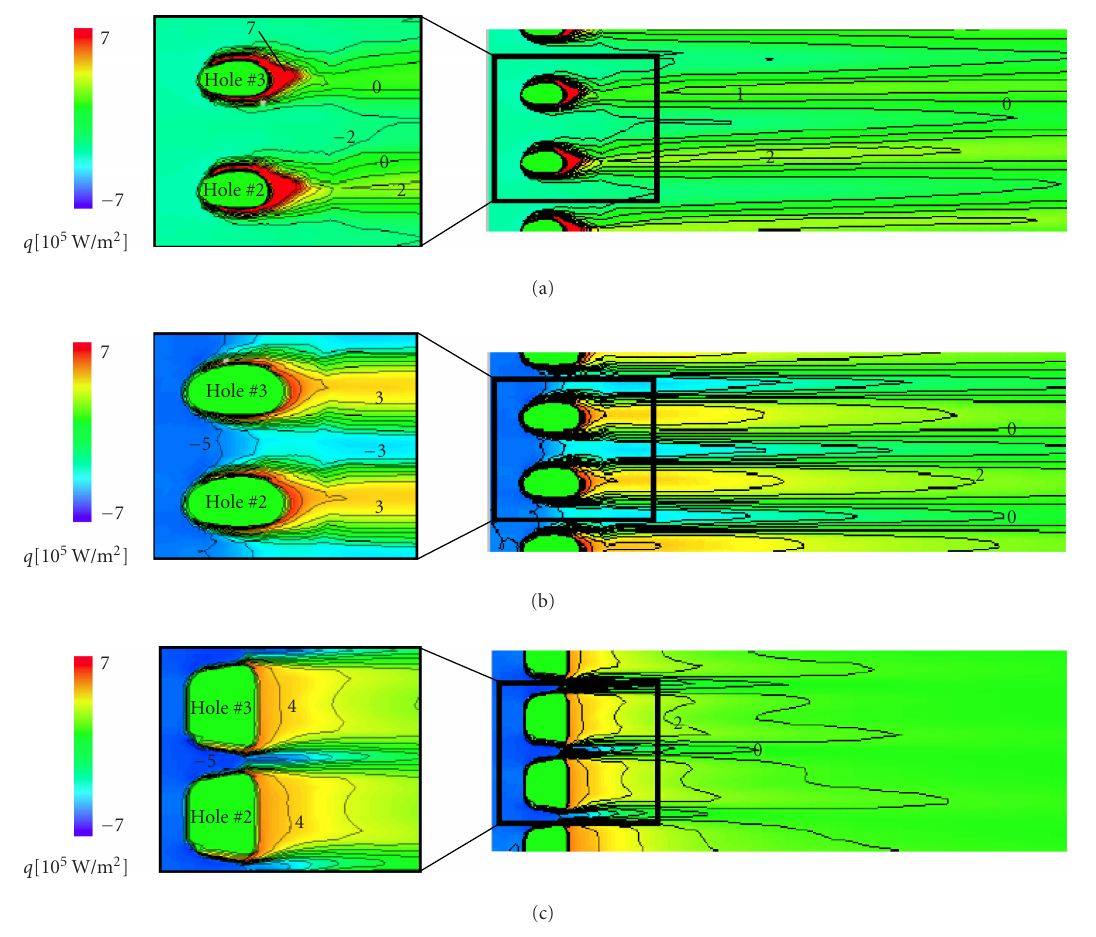
Figure 5: Distribution of the specific heat flux rate for the conjugate surface ( M = 2 . 0): (a) cylindrical hole, (b) di ff user hole, and (c) fanshaped